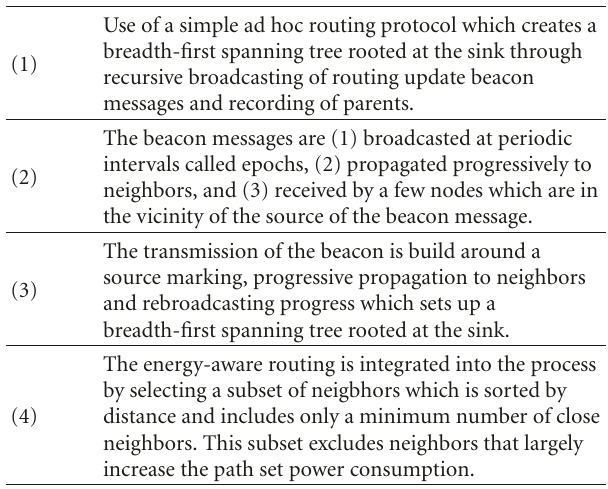
Table 1: The ECMP key